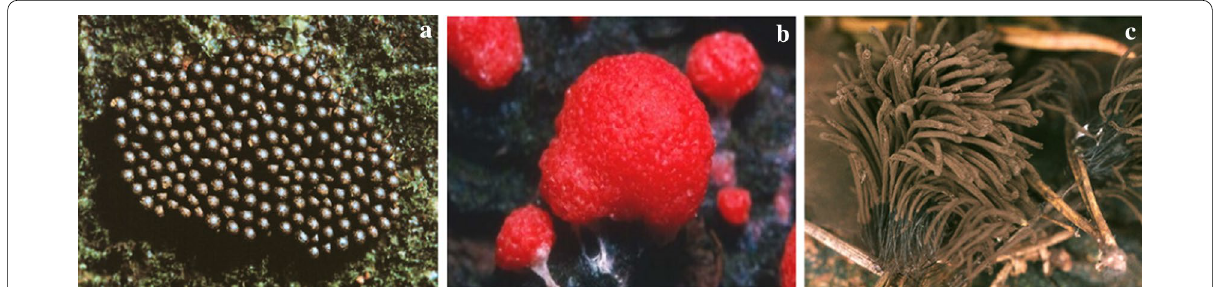
Fig. 9 a Lindbladia tubulina Fr, b Tubifera ferruginosa (Batsch) Gmelin, c Stemonitis fusca Roth (https:// www. disco verli fe.